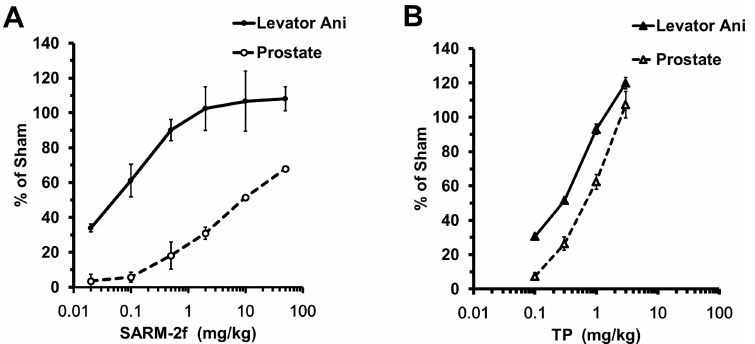
Fig 1. Tissue specificity of SARM-2f and testosterone propionate (TP) in castratedrats. Effect of SARM-2f (A) and TP (B) on the levator ani muscle weight and prostate weight. The y axis representspercent (%) of the sham group. The drug was administeredto castrated male rats for three weeks. Data are shown as the means ± SD (n =